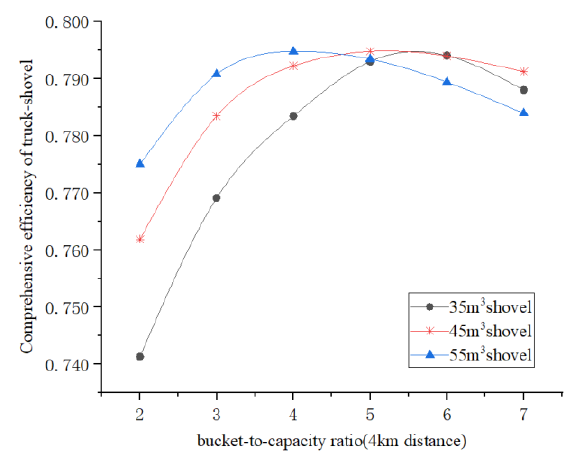
Figure 3. Relationship curves at 4 km transport distance.